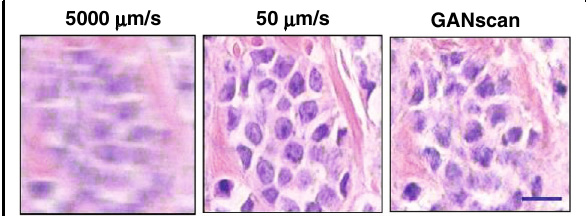
Fig. 1 A demonstration of motion deblurring by GANscan. The results closely resemble the control specimen, with 100x times the acquisition